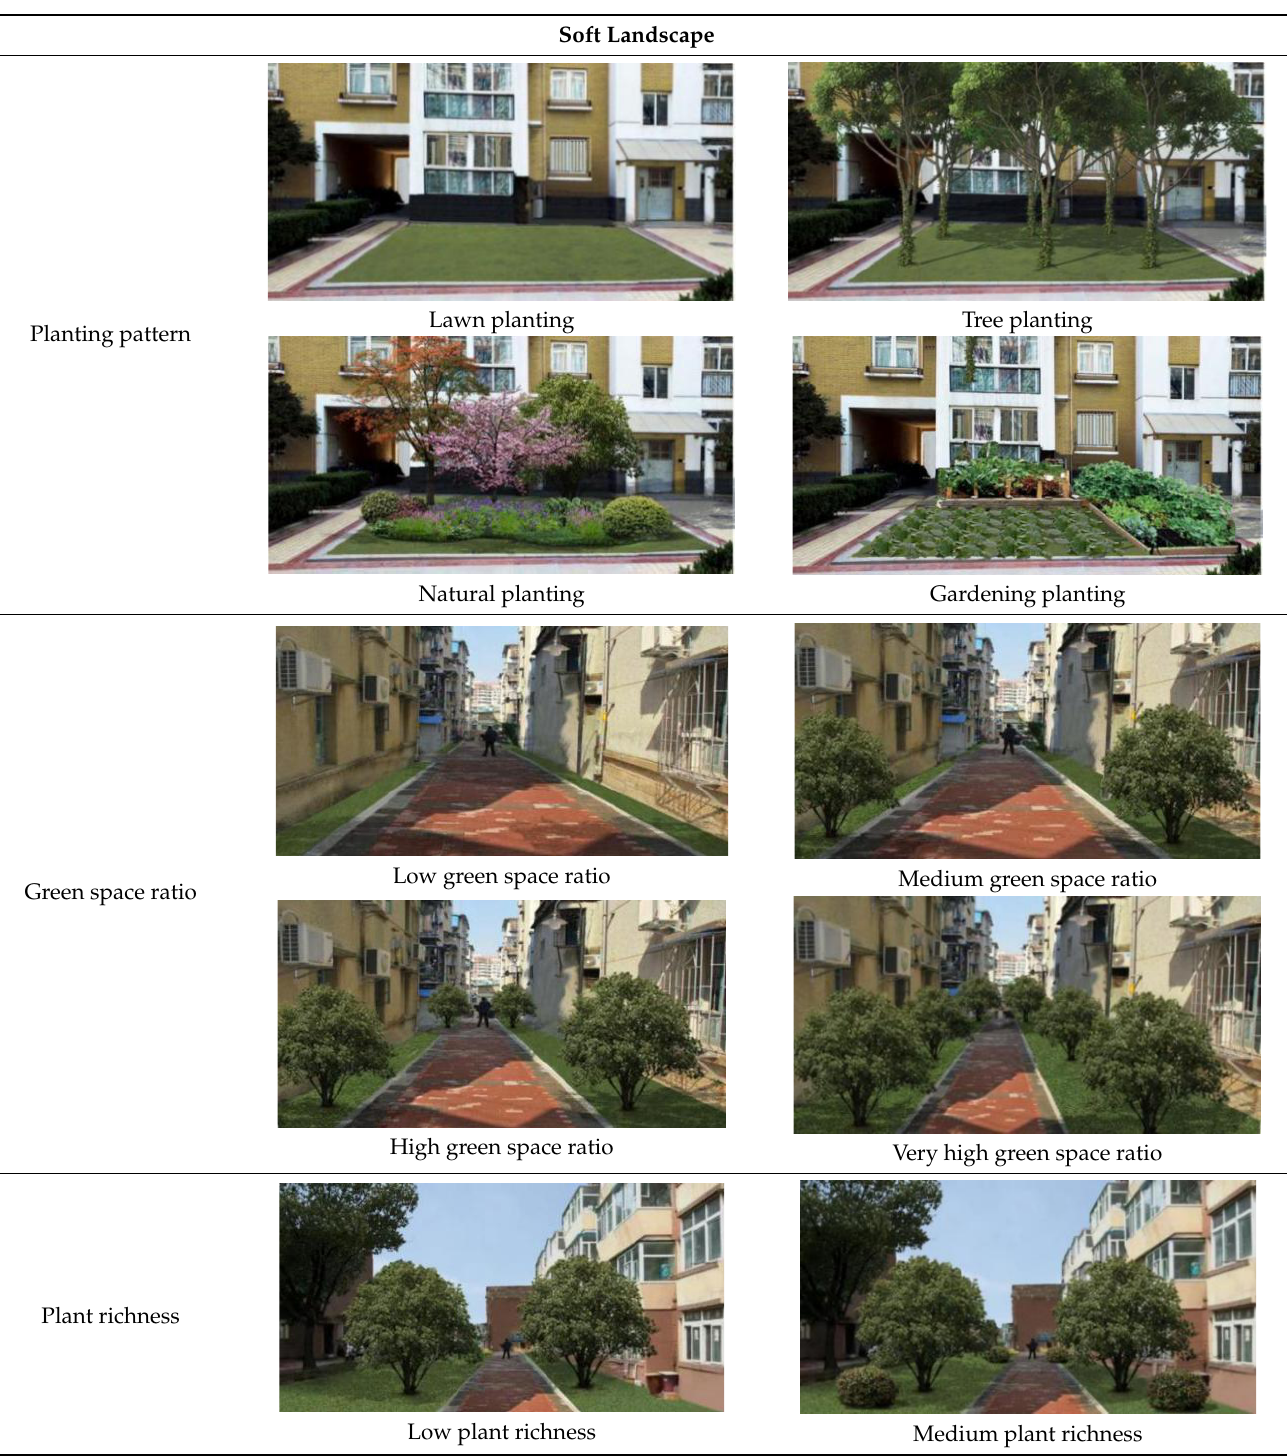
Table A1. The physical characteristics of the six landscapes. Soft Landscape